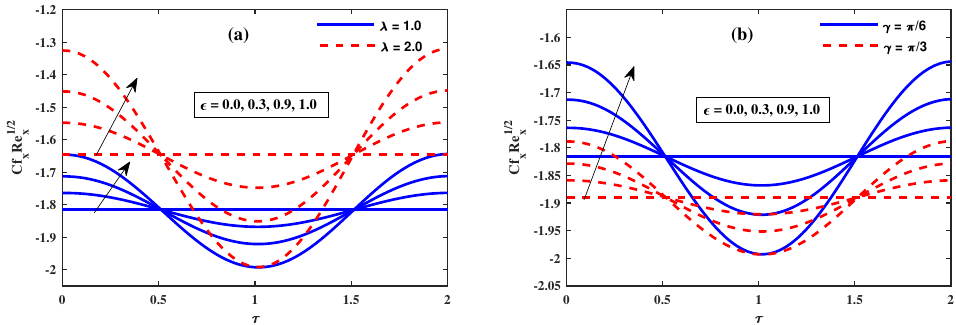
Figure 8. Fluctuation of Cf x Re 1/2 x against (cid:101) (amplitude), ( a ) λ (mixed convection parameter), and ( b ) γ (inclined angle).